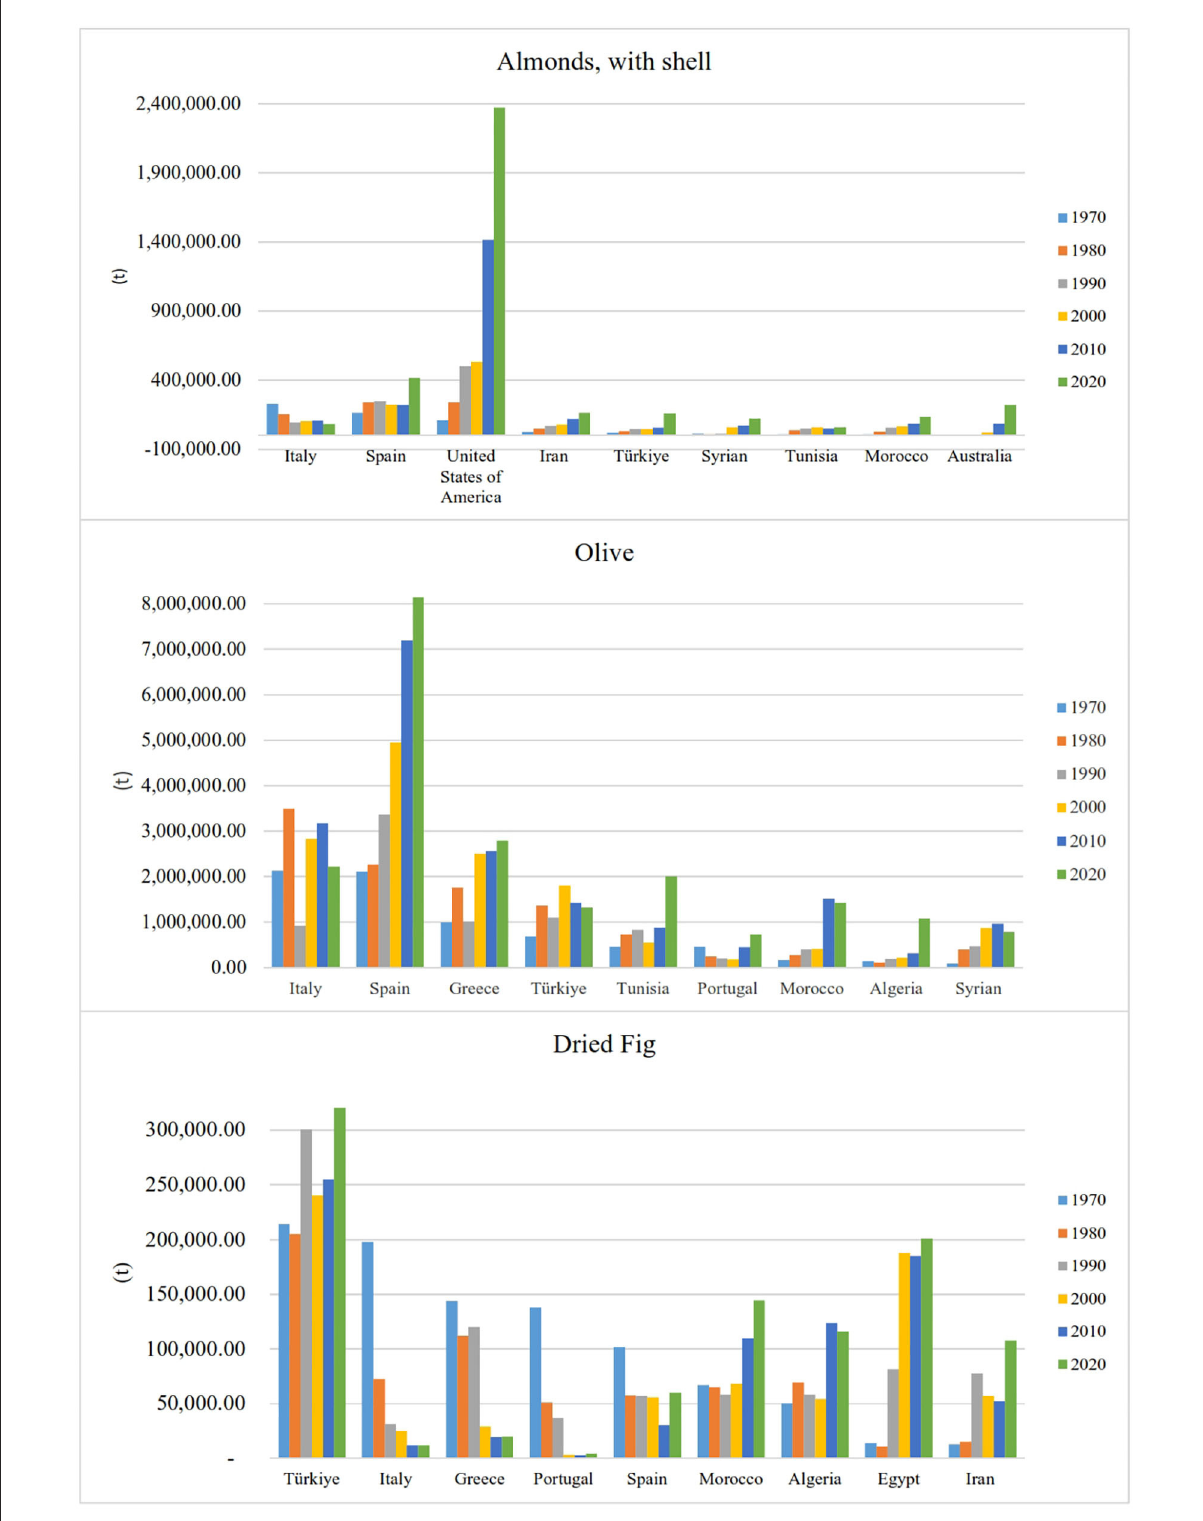
FIGURE1 Production trends in the main producing countries (Source: Authors’